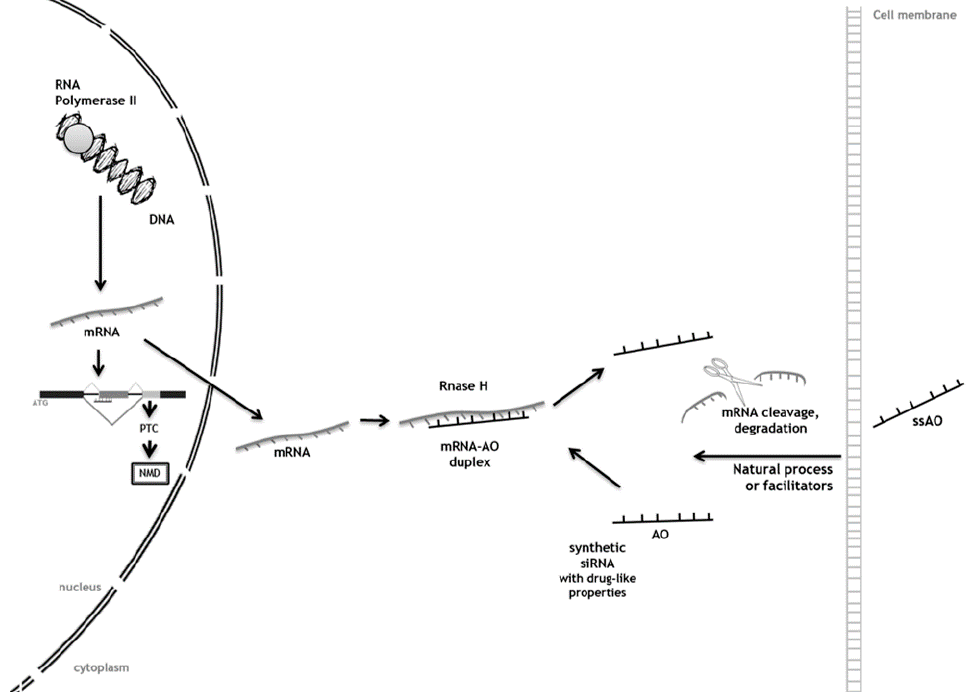
Figure 2. Single stranded antisense oligonucleotide (AO) pathways for gene knockdown: two